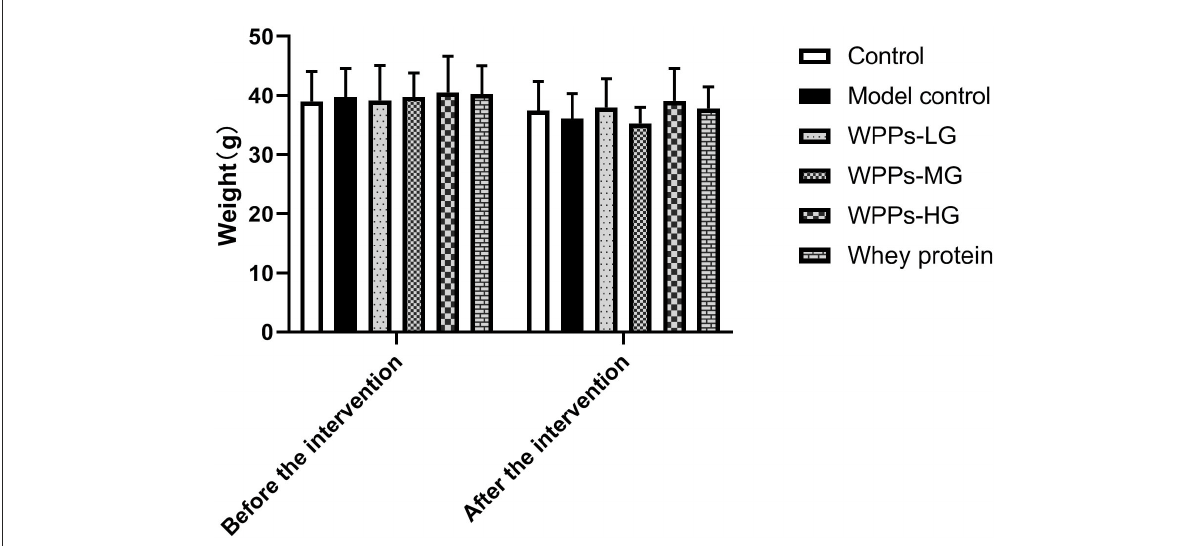
FIGURE1 Effects of WPPs on body weight. Data are expressed as means ± SD ( n = 12). Whey protein group at a dose of 1.5 g/kg; WPPs-LG, whey protein peptides low-dose group at a dose of 0.3 g/kg; WPPs-MG, whey protein peptides medium dose group at a dose of 1.5 g/kg; WPPs-HG, whey protein peptides high-dose group at a dose of 3.0 g/kg.